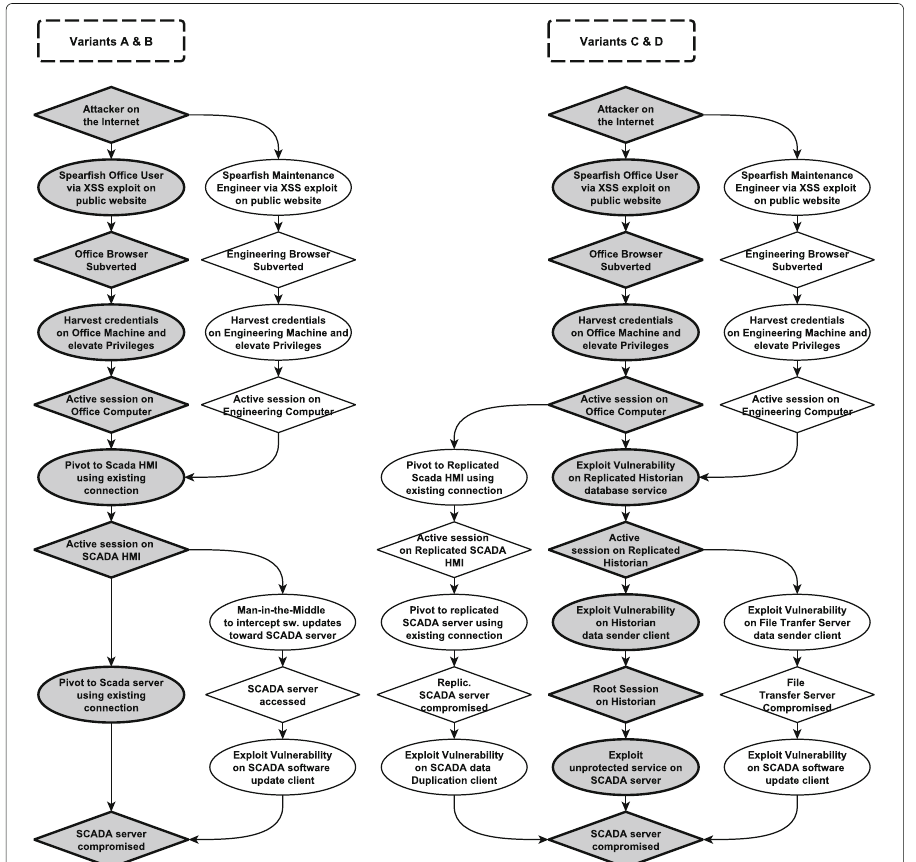
Fig. 7 Aggregated attack graph of an attacker positioned on the